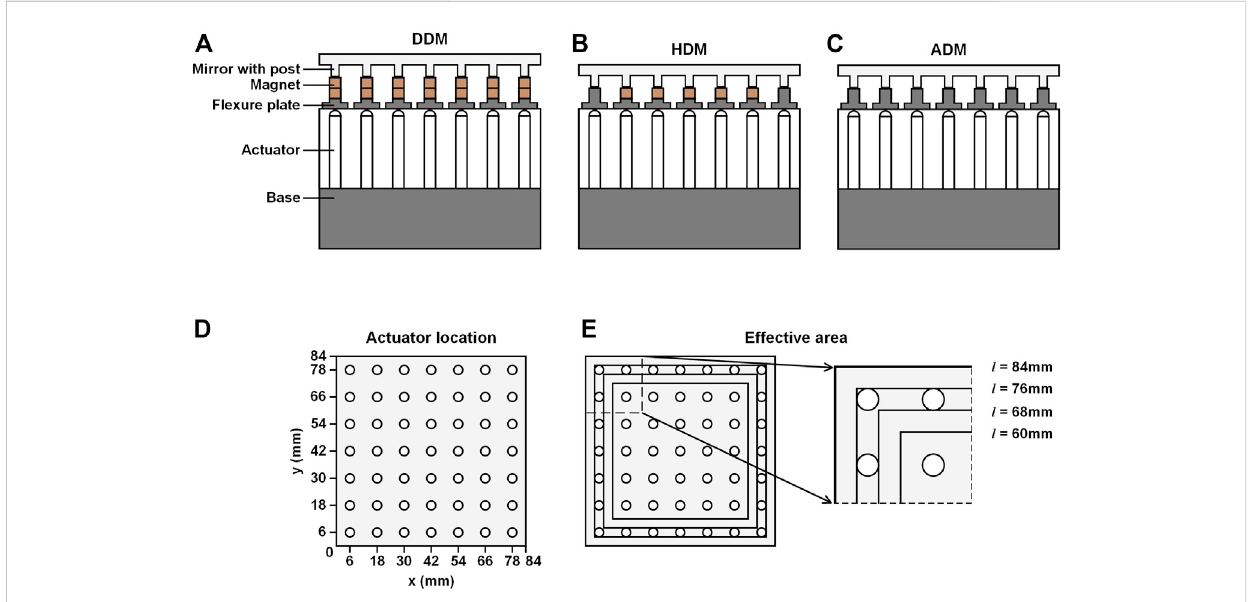
FIGURE 1 Schematic view of the structure of the DM. (A) DDM. (B) HDM. (C) ADM. (D) Actuator location ( φ = 5 mm). (E) Effective area sizes of the DDM. l : Side length of the effective area.